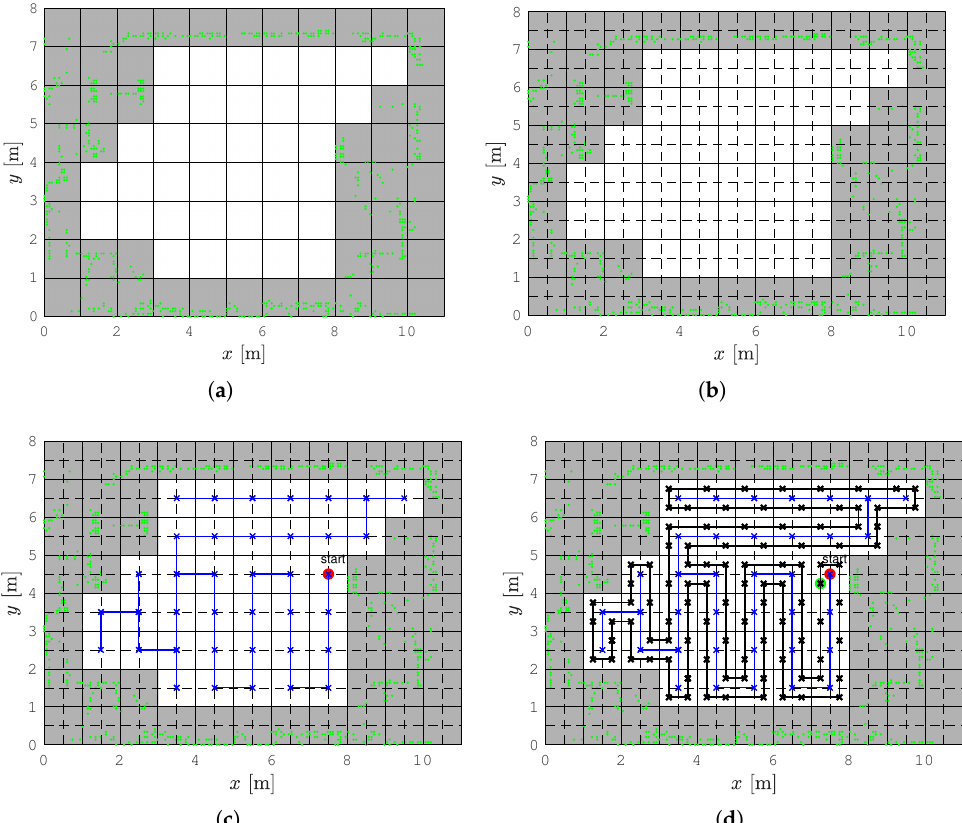
Figure 3. Example of the complete coverage path planning for the known environment step-by-step. The real obstacles collected by SLAM algorithm are presented with green dots. ( a ) Low resolution occupancy grid map, ( b ) Subdividing of grid cells, ( c ) The spanning tree (blue line), ( d ) Complete coverage path (black